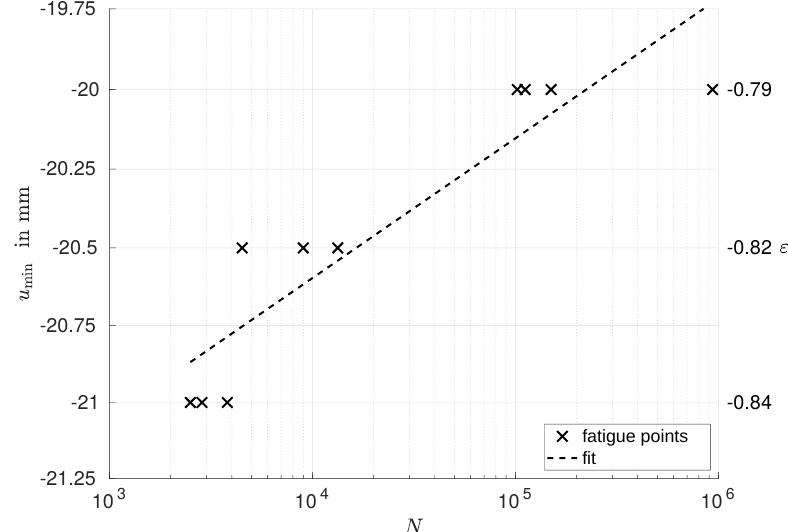
Figure 8. Fatigue results in the compression range for filled EPDM rubber (displacement-controlled tests).